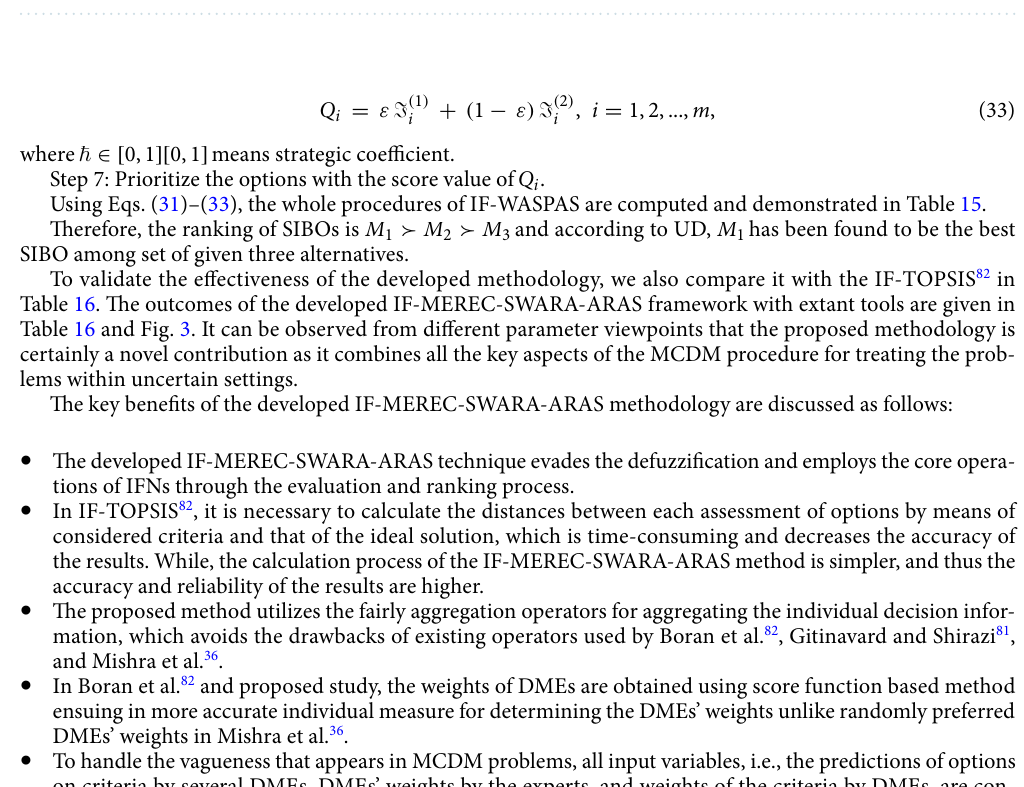
Table 8. Objective weights for SDIs using